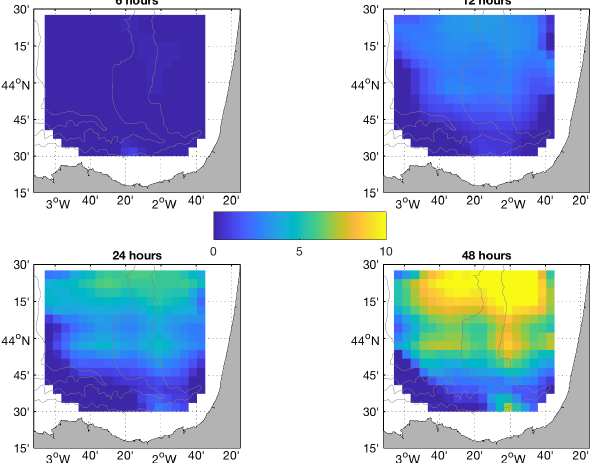
Figure 11. Spatial distribution of separation distances [km] between trajectories using L-STP and persistent currents at 6, 12, 24, and 48h for the Red Sea HFR